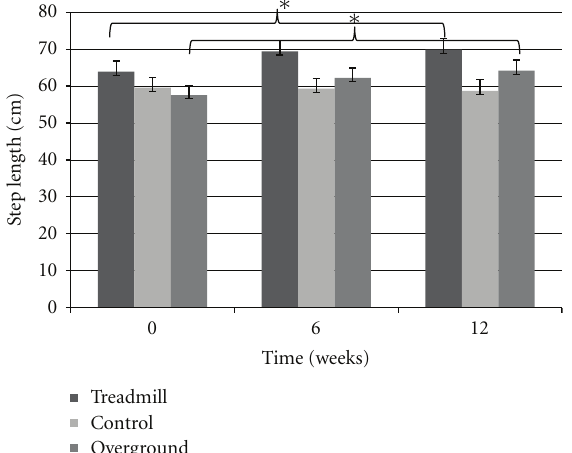
Figure 2: Velocity increases ∼ 10cm/s after 12-weeks (retention test) in only TG and